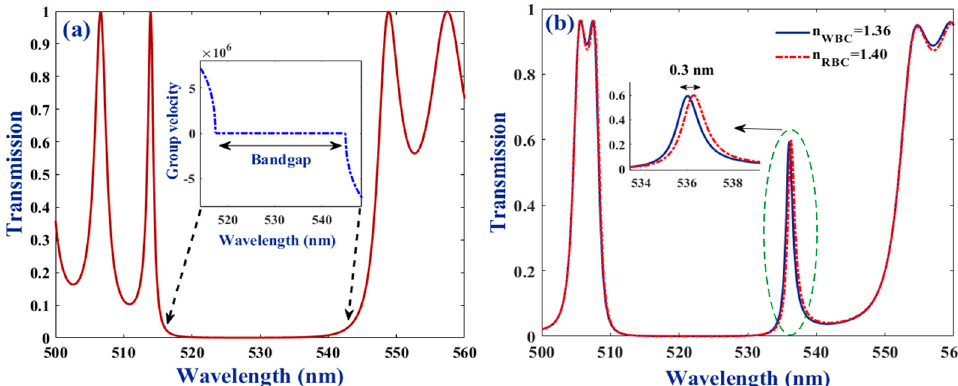
Figure 2. Transmission spectra for ( a ) an ideal perfect crystal made of 8 periods of (ZnS/Ge) unit- cells, ( b ) bio-chip, including 4 periods of unit-cells at each side of the single bio-cell. The inset in panel ( a ) indicates GV for the ideal crystal in the 518–545 nm wavelength range. The parameters θ = 0°, Ɛ s = 0.2, ψ = 30°, µ c = 0.2 eV, d Ge = 200 nm, d ZnS = 330 nm, and d bio = 90 nm have been considered in simulations.